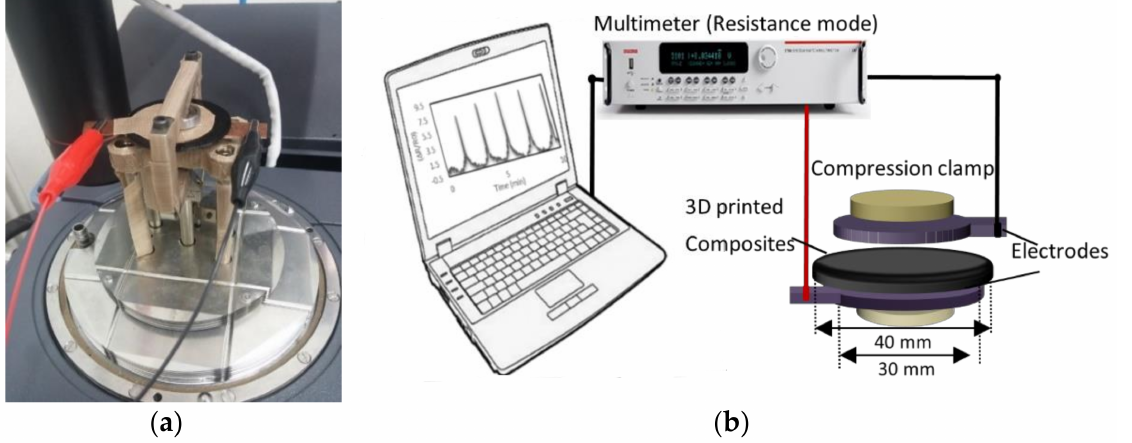
Figure 1. ( a ) Sample setup applied to investigate the piezoresistive properties of 3D-printed nanocom- posite layers under compressive stress; ( b ) Schematic diagram of the positioning of the sample in clamps and